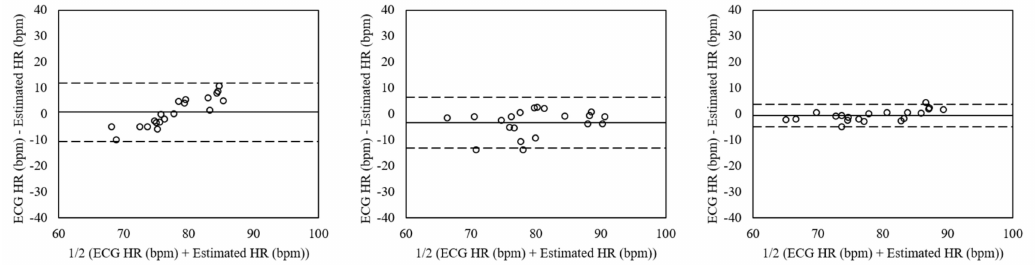
Figure 10. Bland–Altman plots of heart rates estimated from the dataset including the motion artifacts by facial expressions using peak detection ( Left ), FFT ( Mid ), and clustering ( Right ). The lines are the mean errors and 95%